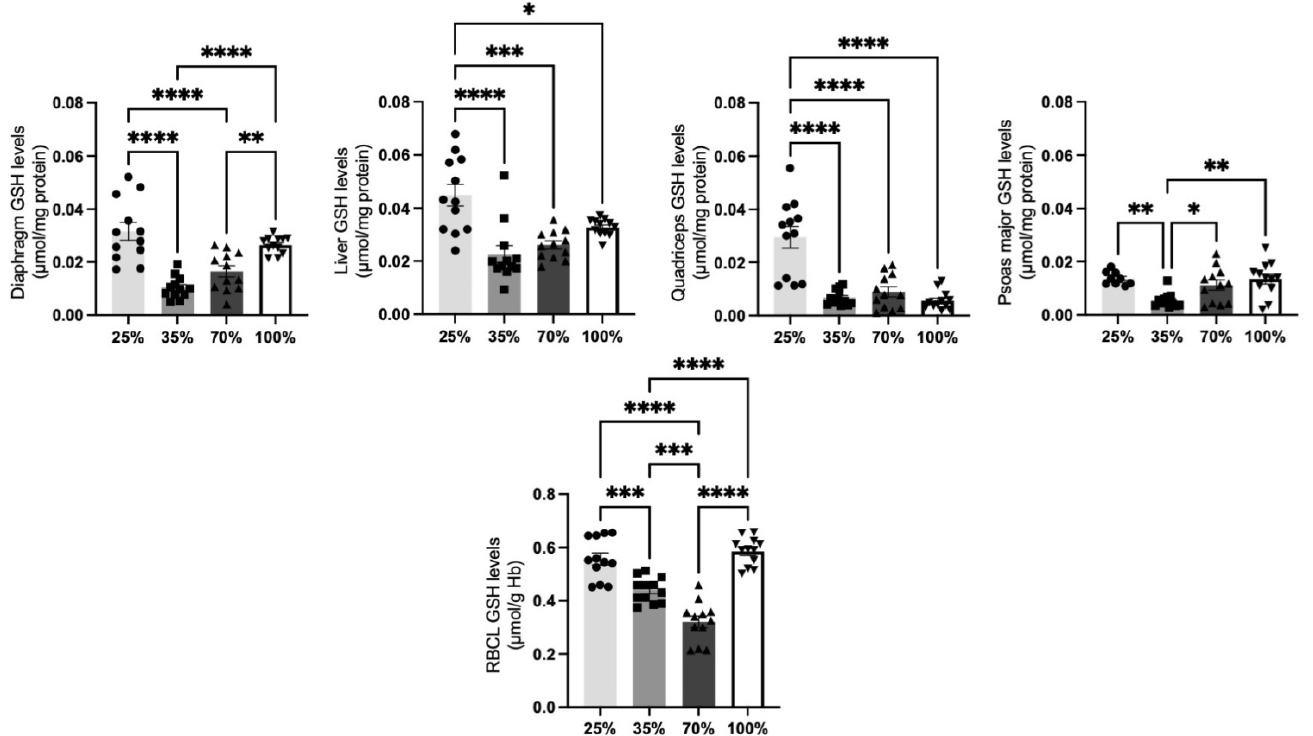
Figure 5. GSH levels at all 4 d.s. of kids. * denotes significant difference with p < 0.05, ** denotes significant difference with p < 0.01, *** denotes significant difference with p < 0.001, **** denotes significant difference with p < 0.0001.